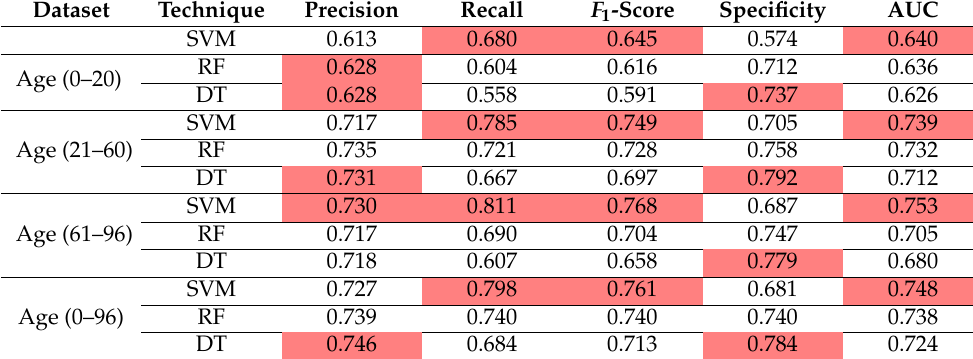
Table 4. Precision, recall, F 1 -score, specificity, and AUC results for SVM, RF and DT techniques categorized by age ranges. Intense red indicates the highest